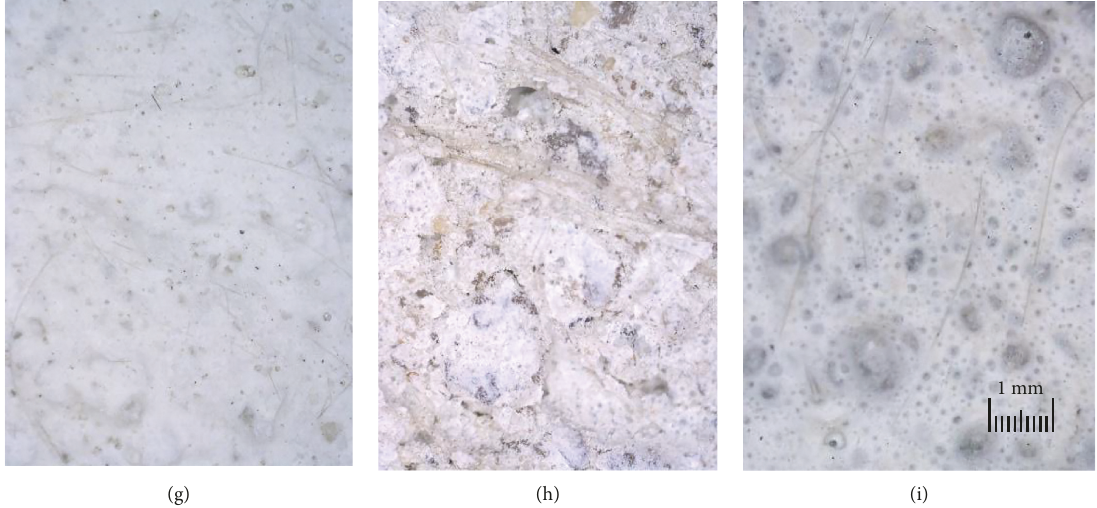
Figure 5: Microstructure of all tested samples and scale used in